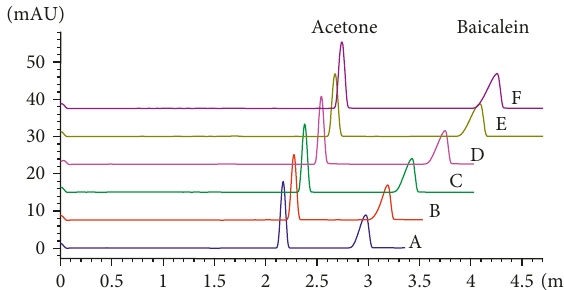
Figure 3: Electrophoregrams of baicalein and acetone in running buffers containing different concentrations of thrombin. Thrombin concentration in running buffer: 0U/mL (a), 0.4 U/mL (b), 0.8 U/mL (c), 1.2 U/mL (d), 1.6 U/mL (e), and 2.0U/mL